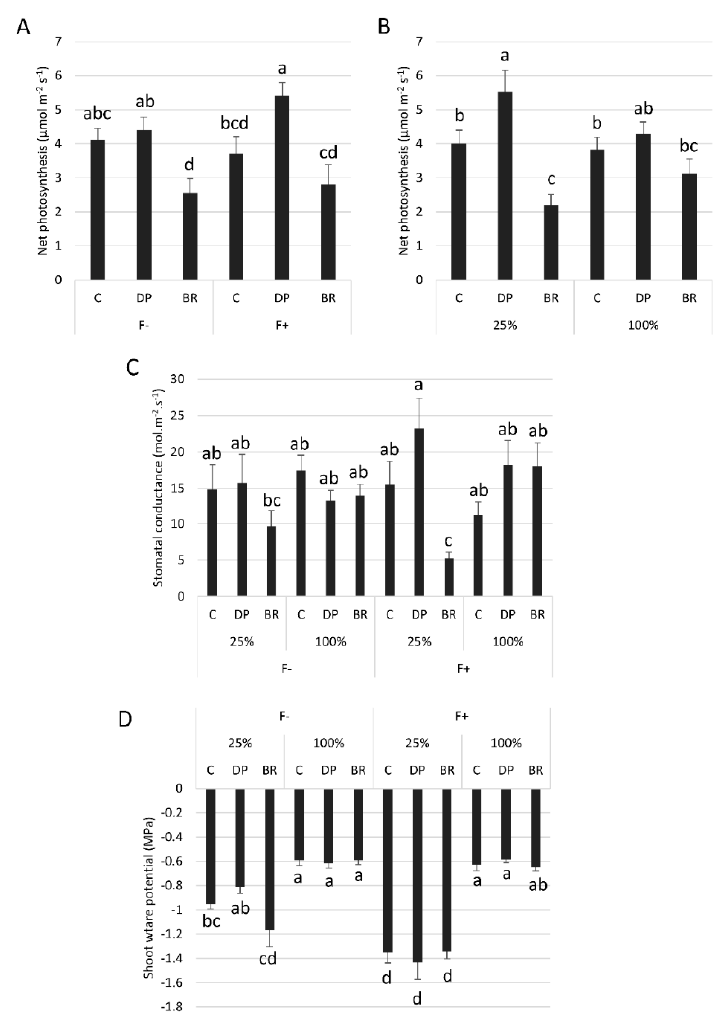
Figure 4. Mean net photosynthesis according to ( A ) stock type × fertilization (F − without and F+ with fertilization) and ( B ) stock type × irrigation (25% or 100% field capacity). Effects of stock type × irrigation × fertilization on ( C ) stomatal conductance and ( D ) shoot water potential. Bars with the same letter indicate a non-significant difference at P ≤ 0.05.